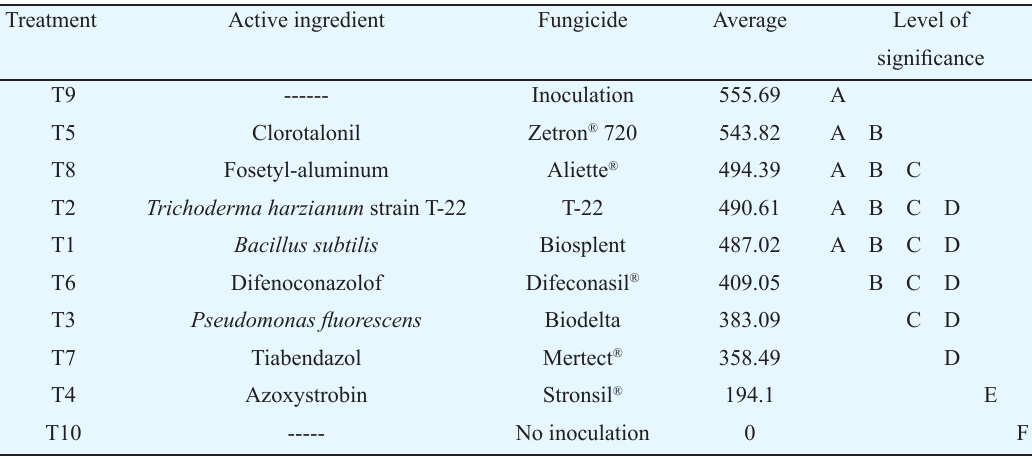
Table 12. Results of the Tukey’s multiple comparison test for the average values of the area under the disease progress